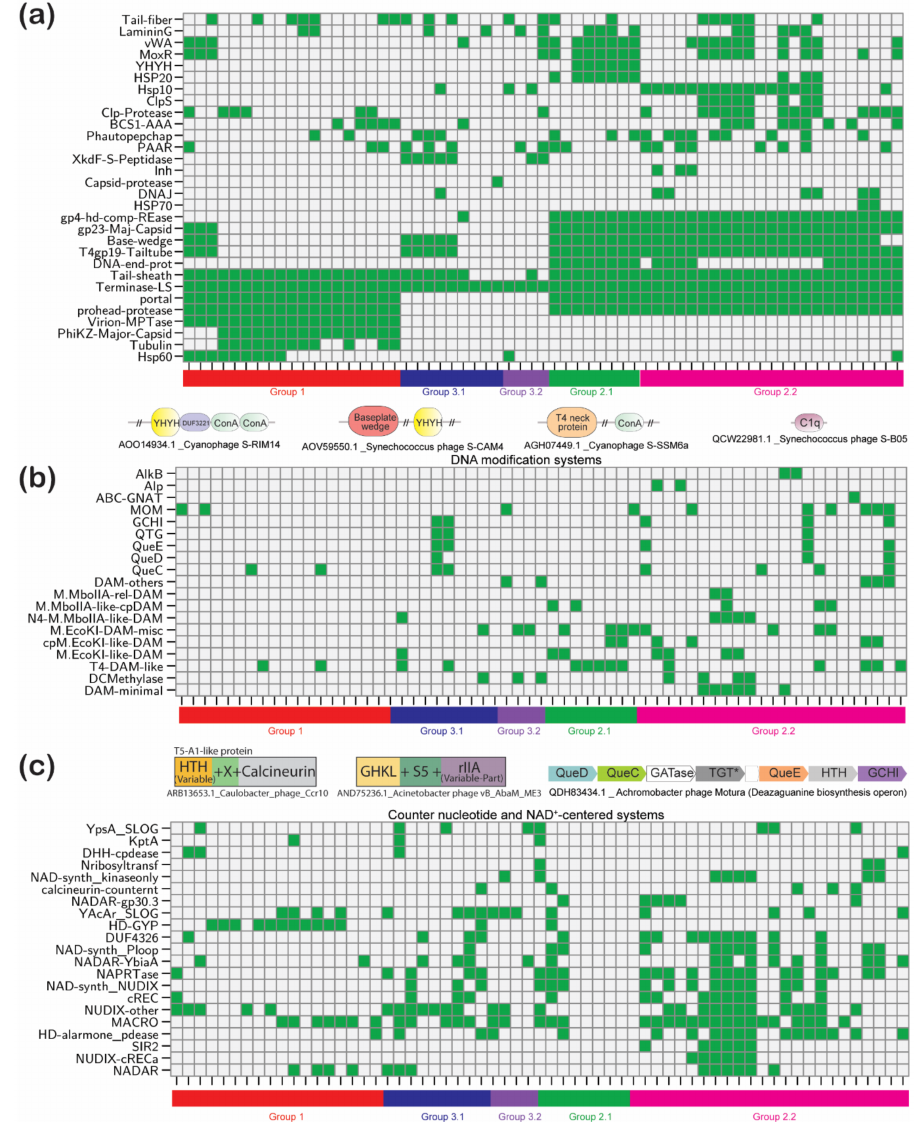
Figure 5. Virion structure and conflict systems. Vector diagrams, domain architectures and operons of ( a ) virion mor- phogenesis and chaperone proteins; ( b ) DNA modification proteins and ( c ) proteins involved in counter nucleotide and NAD + -centric systems. The Canberra distance and Ward clustering were used to determine protein and species order in the vector diagram. Filled green squares indicate presence of a gene. The virus name order and coloring is the same as in Figure 4. Refer to Figure 3 legend for details on domain and gene neighborhood depiction. In domain architecture representations, distinct domains are colored